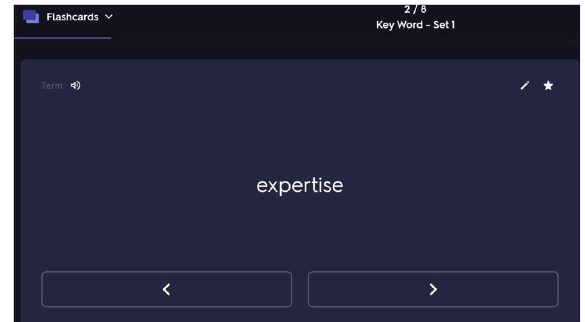
Figure 1: Flashcards Feature.